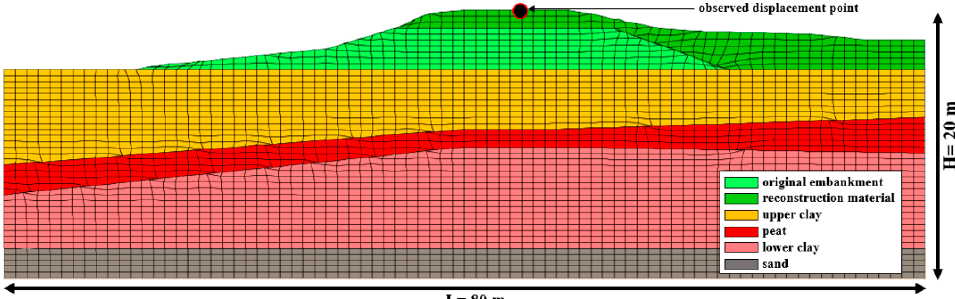
Figure 14. Oostmolendijk numerical model with position of observed displacement point.